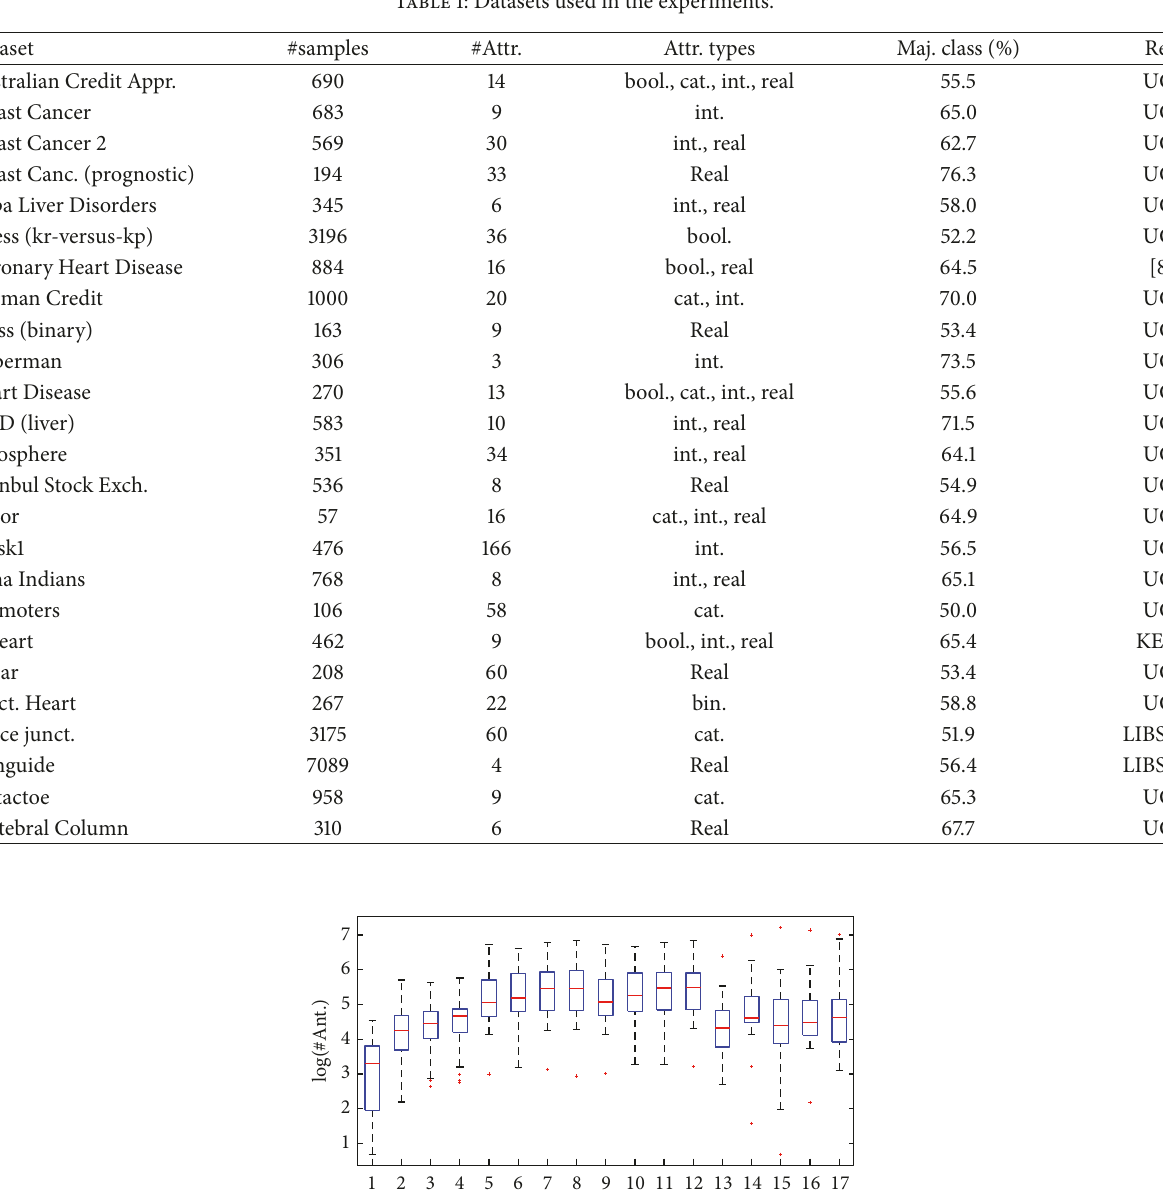
Table 1: Datasets used in the experiments.